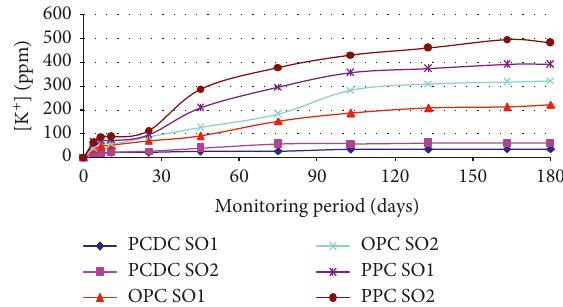
Figure 11: K + analyses in sulphate-simulated